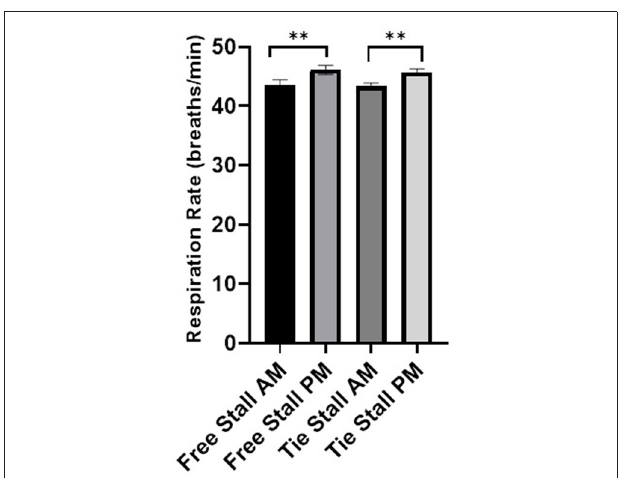
FIGURE 4 | Average respiration rate in breathes per minute for free-stall vs. tie-stall. All data is presented as least squared means of untransformed data, with error bars representing standard error for each mean. Significance [free-stall ( p = 0.01), tie-stall ( p < 0.001)] is represented by double stars above the error bars.